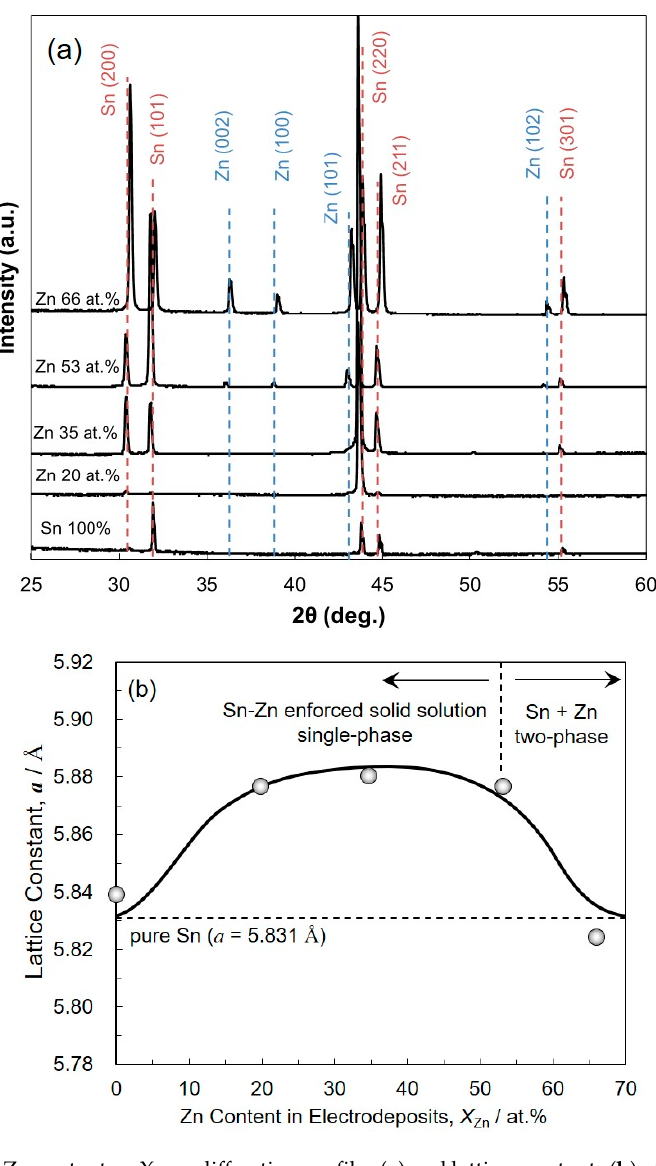
Figure 5. Effect of Zn content on X-ray diffraction profiles ( a ) and lattice constants ( b ) of Figure 5. E ff ect of Zn content on X-ray di ff raction profiles ( a ) and lattice constants ( b ) of electrodeposited electrodeposited Sn-Zn alloy films. Sn-Zn alloy films.